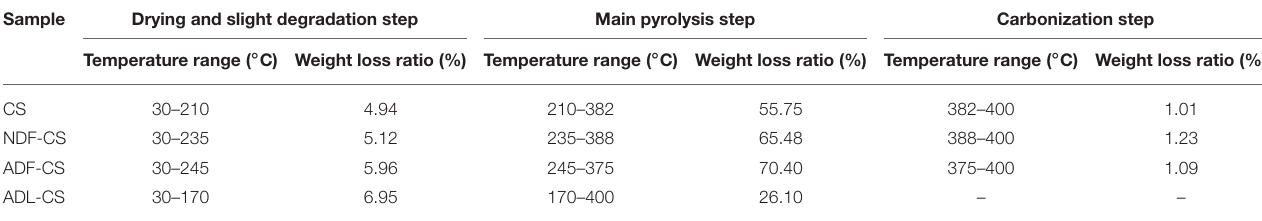
TABLE 3 | Weight loss ratio of CS and its detergent fibers in different pyrolysis stage (30–400 ◦ C). Sample Drying and slight degradation step Main pyrolysis step